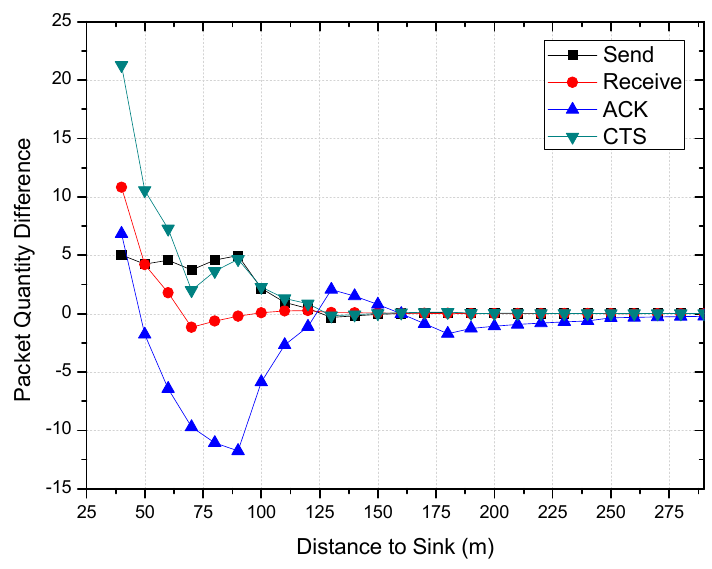
Figure 15. Packet quantity difference under N = 2, r = 60 in COOR(R) method.